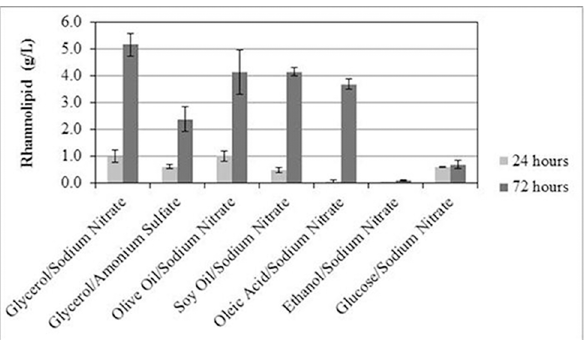
Fig 2. RML production using different carbon and nitrogen sources. Analysesof RML productionby P . aeruginosa -estA were performed using severalvariationsof MSP medium (glycerol, olive oil, soy oil, oleic acid, ethanoland glucoseas carbonsource and sodium nitrate and ammonium sulfate as nitrogensources). Figure presents RML production after 24 (light gray) and 72 hours (dark gray). All cultives were conductedat C/N ratio of 83.2